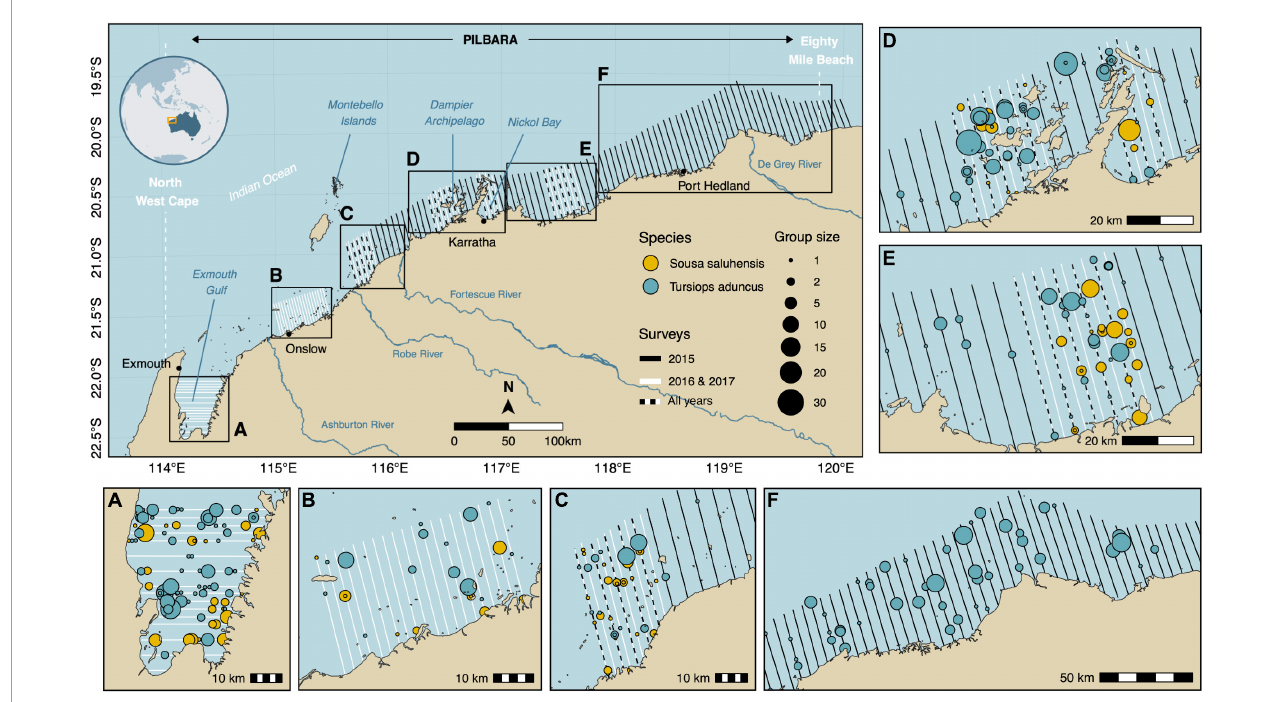
FIGURE1 Map of the study area showing the location of transect lines for each survey time period. Detections of Australian humpback dolphins ( Sousa saluhensis ) and Indo-Pacific bottlenose dolphins ( Tursiops adunc us) appear as filled circles in the map insets. (A) Exmouth Gulf, (B) Onslow and Thevenard Island, (C) Great Sandy Islands, (D) Karratha and Dampier Archipelago, (E) Balla Balla and (F) Port